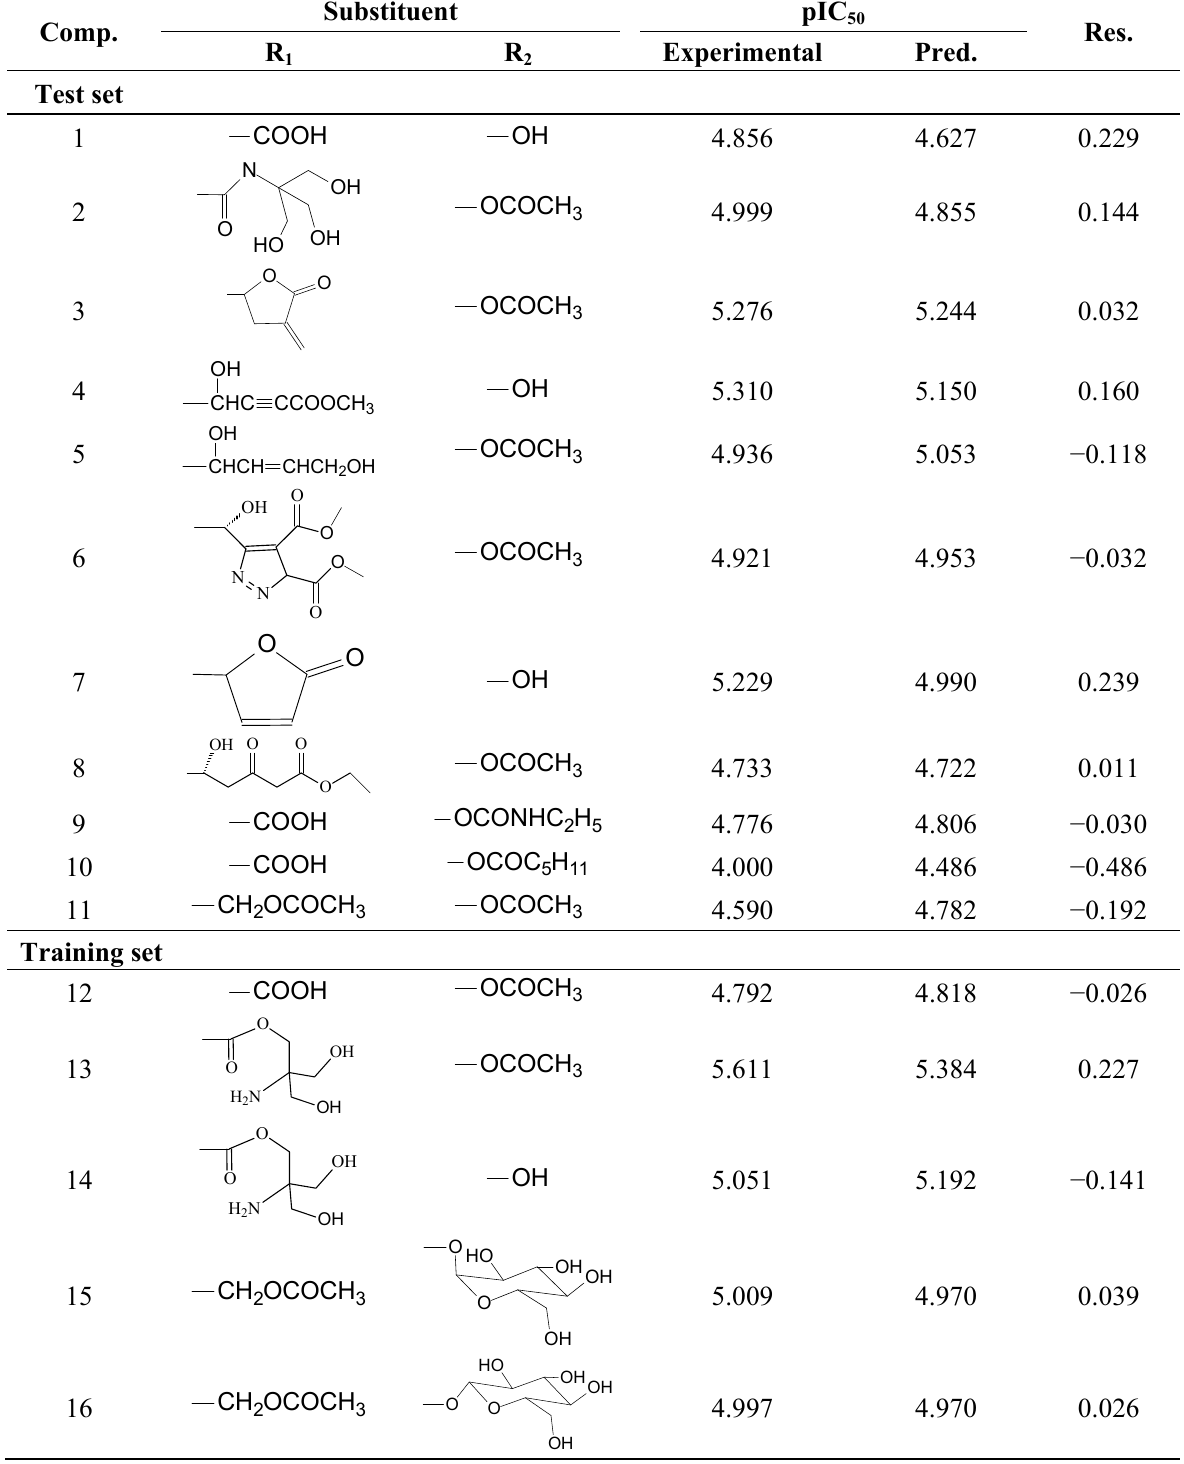
Table 1. The experimental pIC the training and test set molecules using topomer CoMFA. Comp.